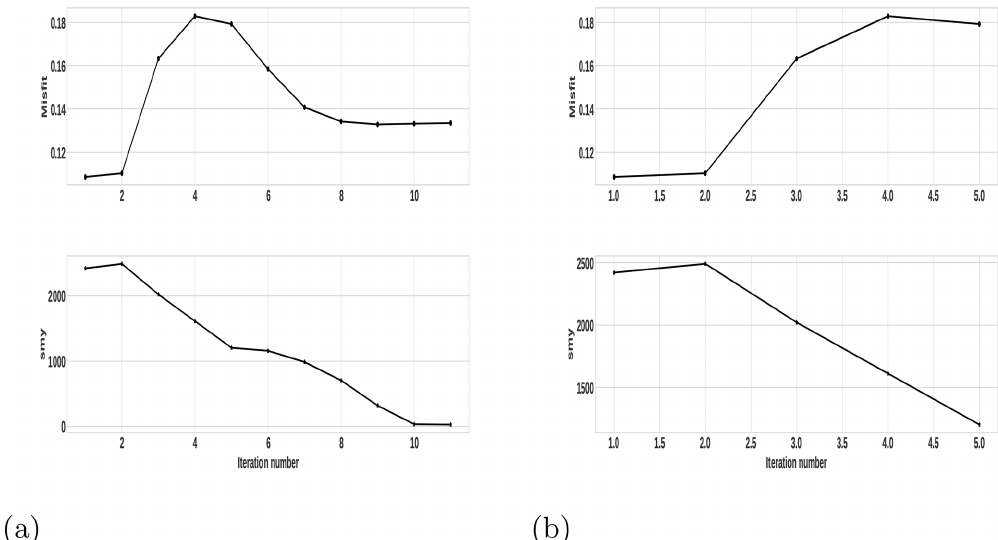
Figure 10. The progression of misfit and smy in the course of the iteration during the inversion of the fourth example’s synthetic data (a) using the proposed combined stopping condition and (b) using only | misfit k − 1 − misfit k | ≤ µ